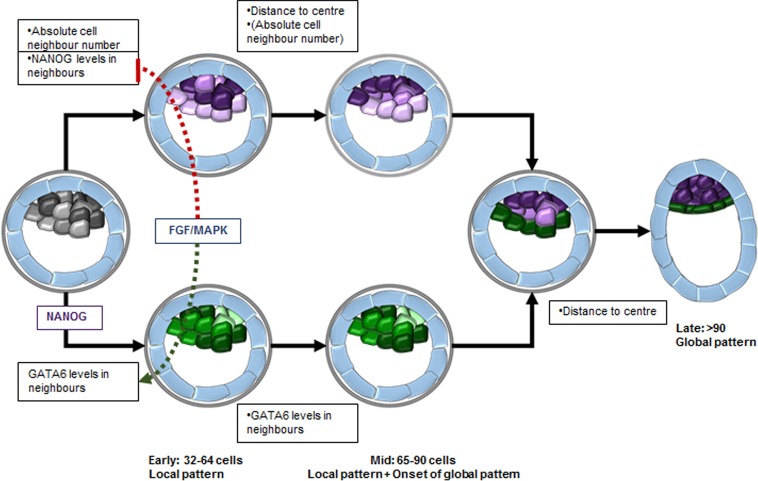
Model for transition from local to global patterns during cell fate decision in the ICM from early to late blastocysts.In early blastocysts, the majority of the ICM cells co-express NANOG and GATA6 but at different levels following a three-dimensional local pattern. NANOG levels in a cell correlate with the absolute cell neighbour number: cells with nine neighbours express the highest NANOG levels. GATA6 levels in a cell correlate with the average level expressed in its neighbours, resulting in clusters of cells with similar levels. FGF/MAPK signalling inhibits NANOG expression level clusters, which in turn, likely via NANOG inhibition on GATA6, promote GATA6 clusters. In mid blastocysts, the local patterns are comparable to those in early blastocysts and a global pattern starts to arise in NANOG expressing cells. In late blastocysts, the cells are segregated into two distinct cell groups and show a clear global pattern: NANOG expressing cells are located closest to the ICM centroid, while GATA6 expressing cells are away from the centroid. Hence, expression patterns occur already in early blastocysts, evolve in mid blastocysts and resolve in late blastocysts before the embryo implants. Grey represents NANOG-GATA6 co-expressing cells, purple represents NANOG expression in cells, and green represents GATA6 expression in cells.